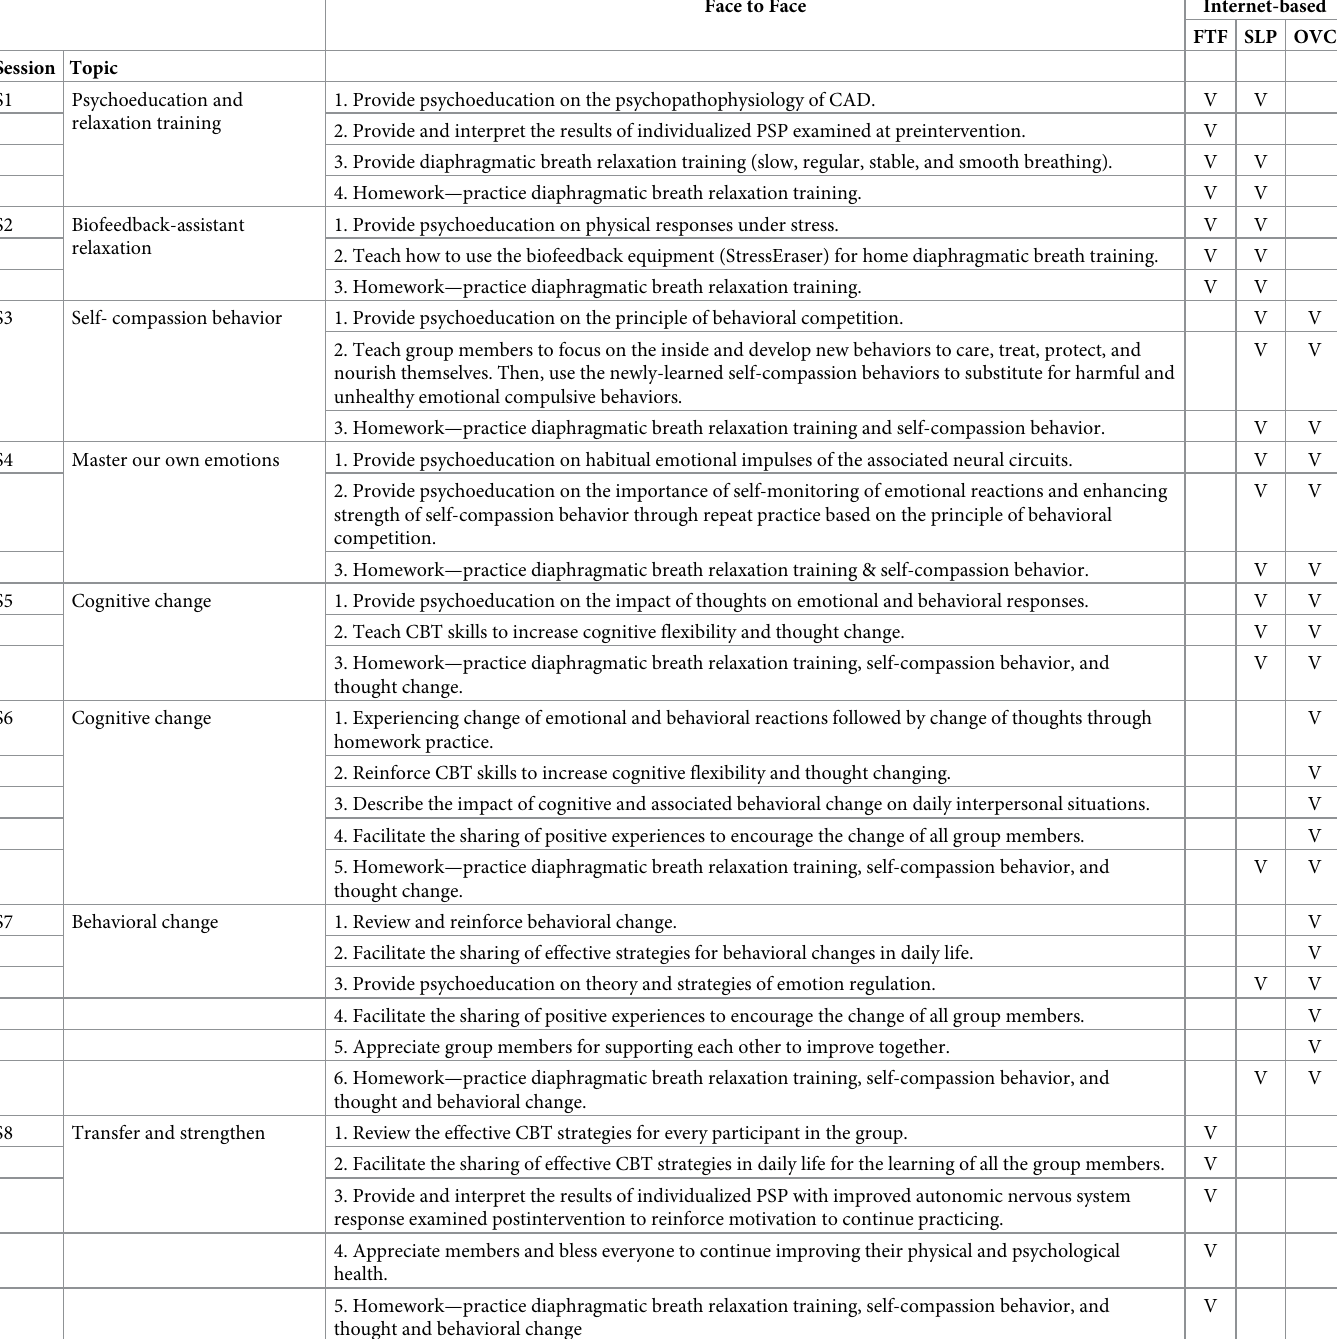
Table 1. Comparison between the face to face and Internet-based cognitive-behavior group therapy protocol for each